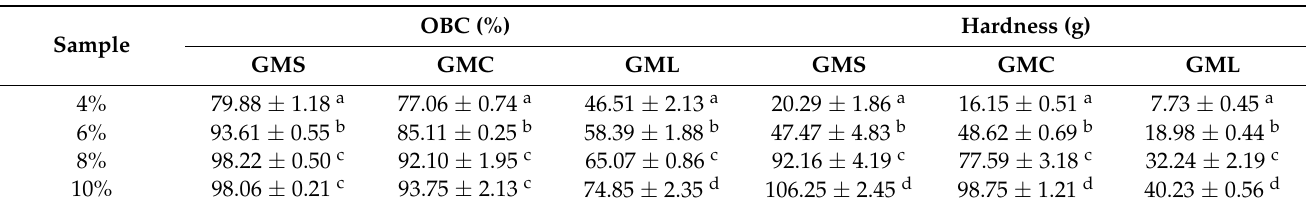
Table 1. The oil binding capacity (OBC) and hardness of the oleogels. Different lower-case letters (a, b, c, d) mean significant differences ( p < 0.05) between different concentrations (the same